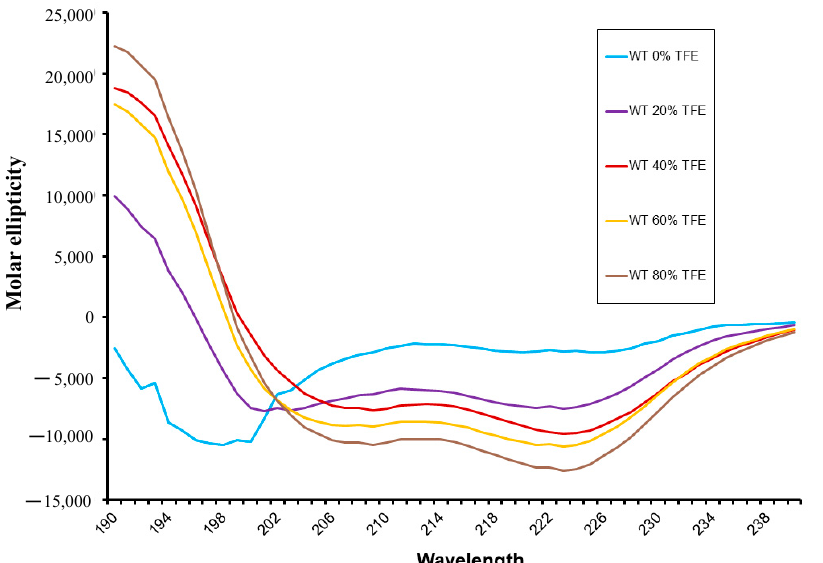
Figure 2. CD of C9h peptide. Data of molar ellipticity versus wavelength in circular dichroism (CD). Data obtained with peptide C9h in 10mM sodium phosphate pH 7.5 (Sky blue curve) are shown together with CD data using 20% (purple), 40% (red), 60% (orange), and 80% (brown) v/v of trifluoroethanol (TFE) in the same buffer. C9h shows a double CD signal at 208 and 222 nm proportional to increasing amounts of TFE indicating a-helix secondary structure content.